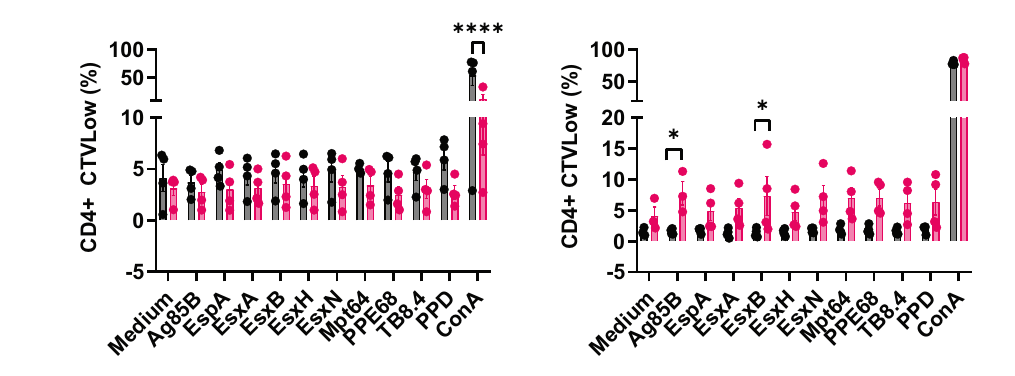
Both CD4 + and CD8 + T cells are required to control primary TB infection. CD4 + T cells help CD8 + T cells maintain effector function and prevent exhaustion, and the synergy between CD4 + and CD8 + T cells promotes the survival of mice infected with Mtb 32 . Our results show that rLm5Ag induces both CD4 + and CD8 + T cell-mediated immune responses in both C57BL/6 and